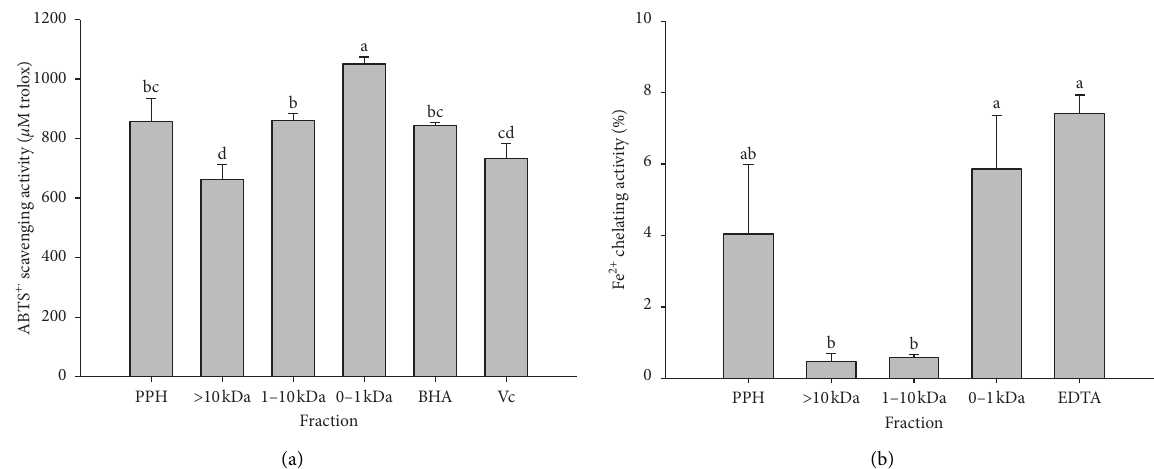
Figure 2: ABTS + • scavenging activity (a) and metal chelating activity (b) of PPH fractions obtained from ultrafiltration using the membrane molecular weight cut-off of 10 and 1kDa at a protein concentration of 1mg/mL (the concentrations of BHA, Vc, and EDTA were 0.1, 0.05, and 1mg/mL, respectively).